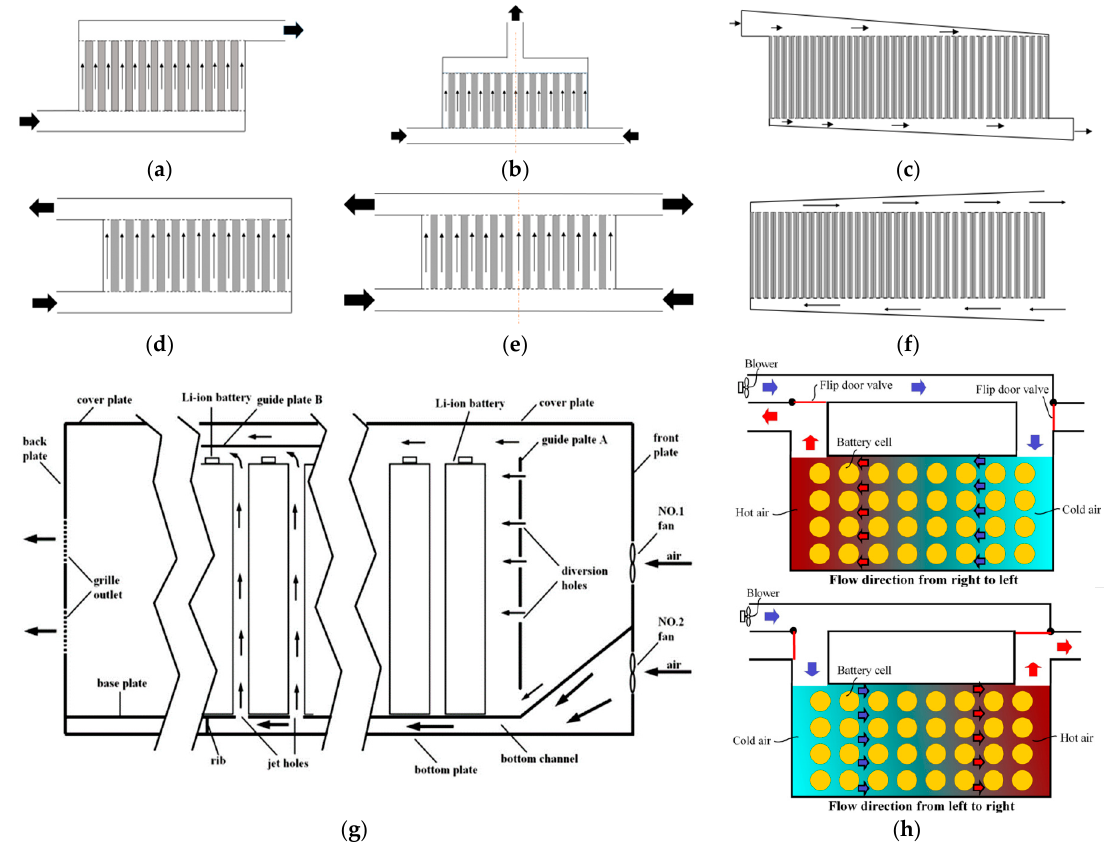
Figure 2. Designs of the flow channel and flow pattern ( a , b , d , e ) “Z-type” flow channel, Symmetrically modified “Z-type”, “U-type” flow channel, Symmetrically modified “U-type” [1], ( c ) Tapered “Z-type” [2], ( f ) Tapered “U-type”, ( g ) Additional duct, Reprint with permission [34]; 2020, Elsevier. ( h ) Reciprocating air flow in two directions. Reprint with permission [35]; 2020, Elsevier.